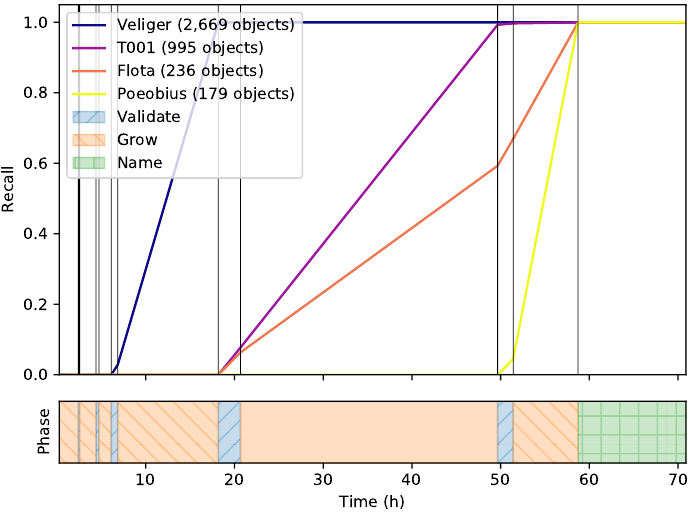
Figure 10. Recall of the indicator classes C i . The time periods are colored according to their respective phase. Veliger is found in the third iteration, T001 and Flota in the fourth, and Poeobius in the last